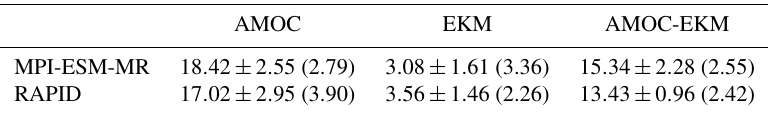
Table 1. Transport mean values, standard deviations and seasonal ranges (in parentheses) for the model (1979–2014) and observed (2004– 2014) AMOC. All values in sverdrups